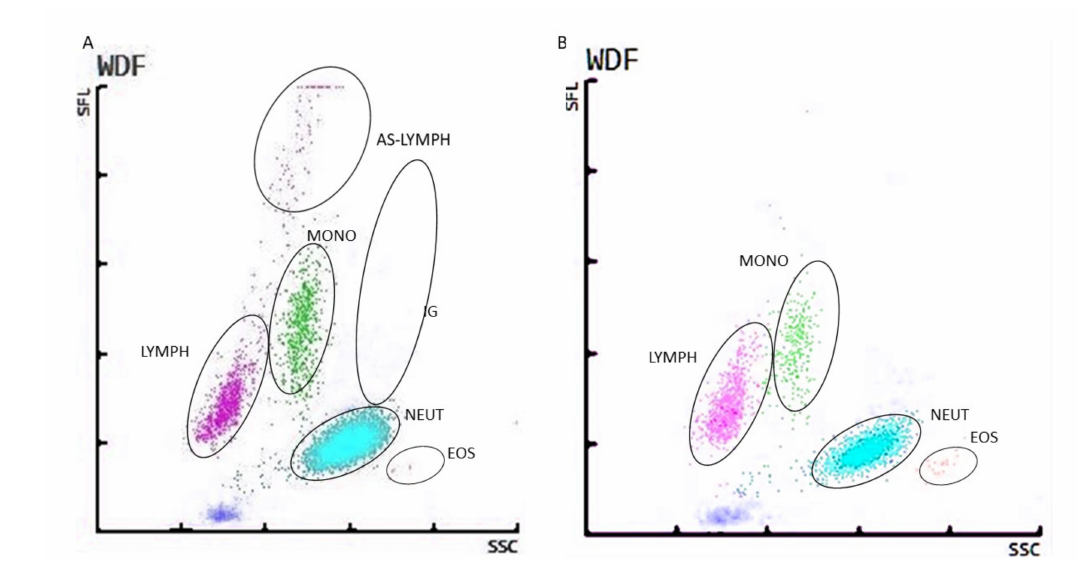
Figure 2. WDF scattergrams of COVID ICU patients ( A ) and non-COVID ICU patients ( B ). Lymph—lymphocytes; Mono— monocytes; Neut—neutrophils; Eos—eosinophils; IG—immature granulocytes; AS-Lymph—antibody-synthesizing